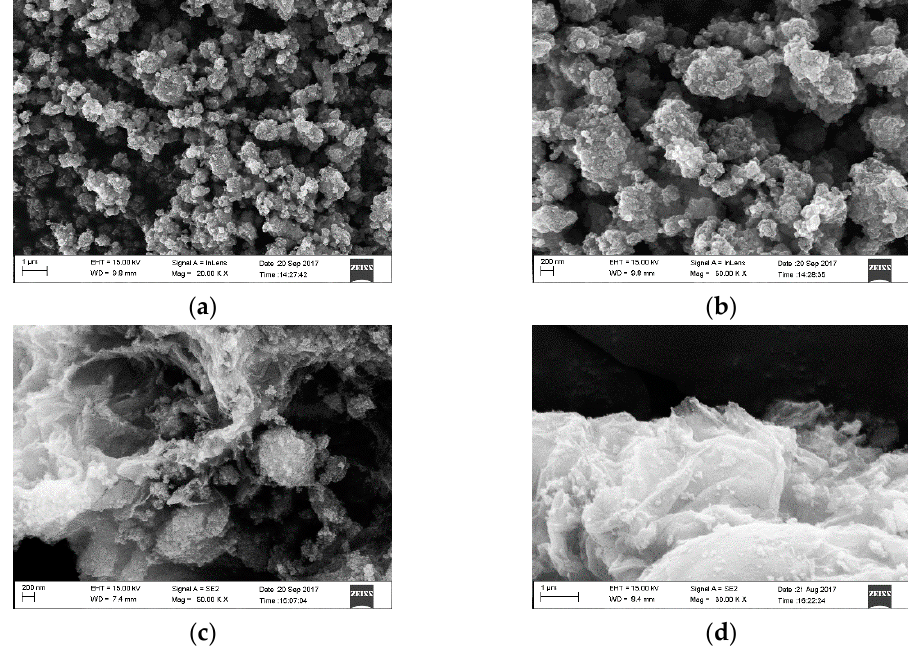
Figure 1. Scanning electron microscope (SEM) images of TiO 2 nanoparticle and composite photocatalyst with graphene oxide (GO): ( a , b ) SEM images of TiO 2 nanoparticle at different resolutions; ( c ) SEM images of composite photocatalyst at 3% GO content; ( d ) SEM images of composite photocatalyst at 23% GO content.